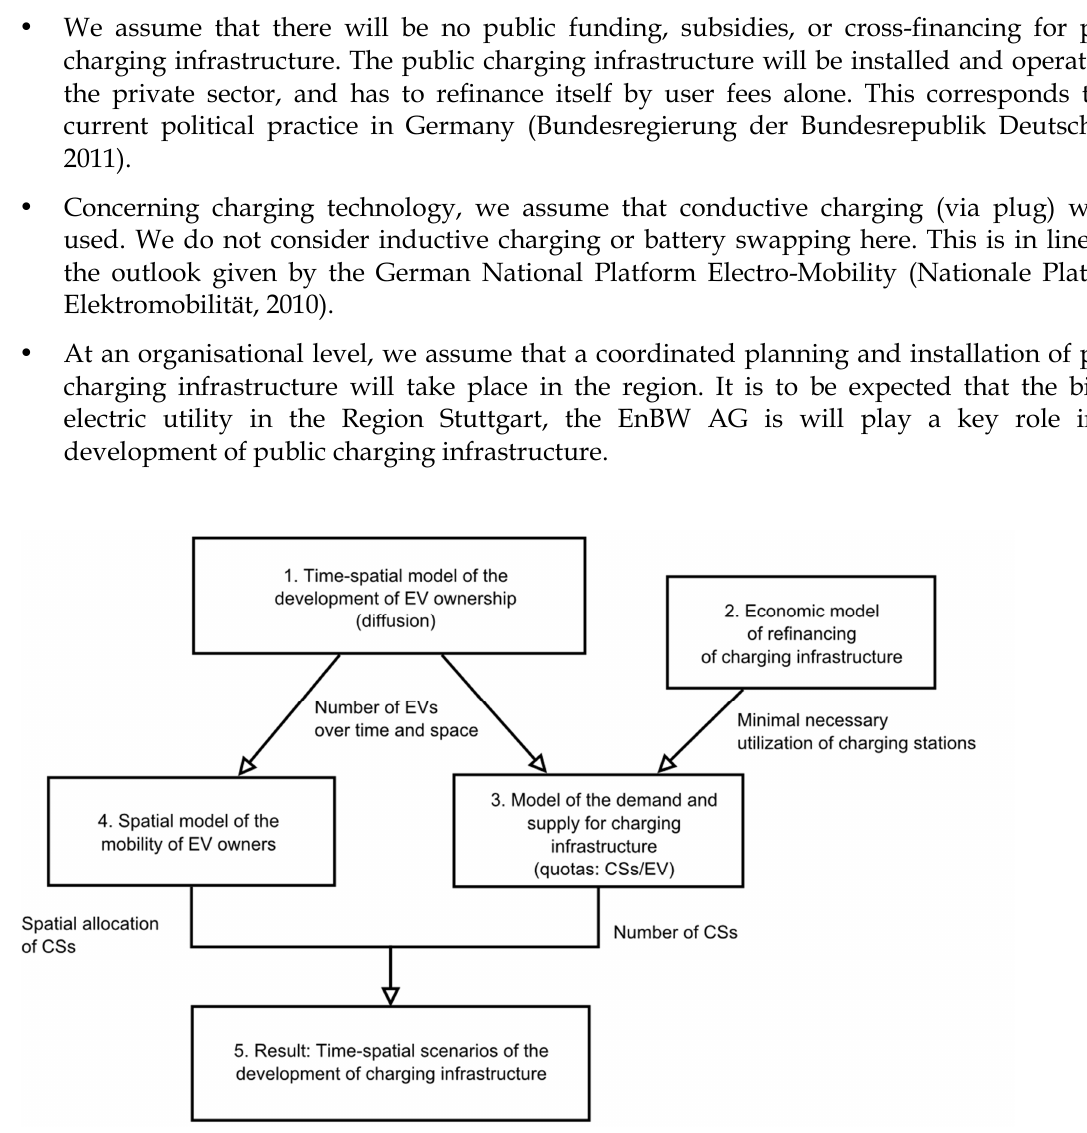
Figure 1. General structure of the